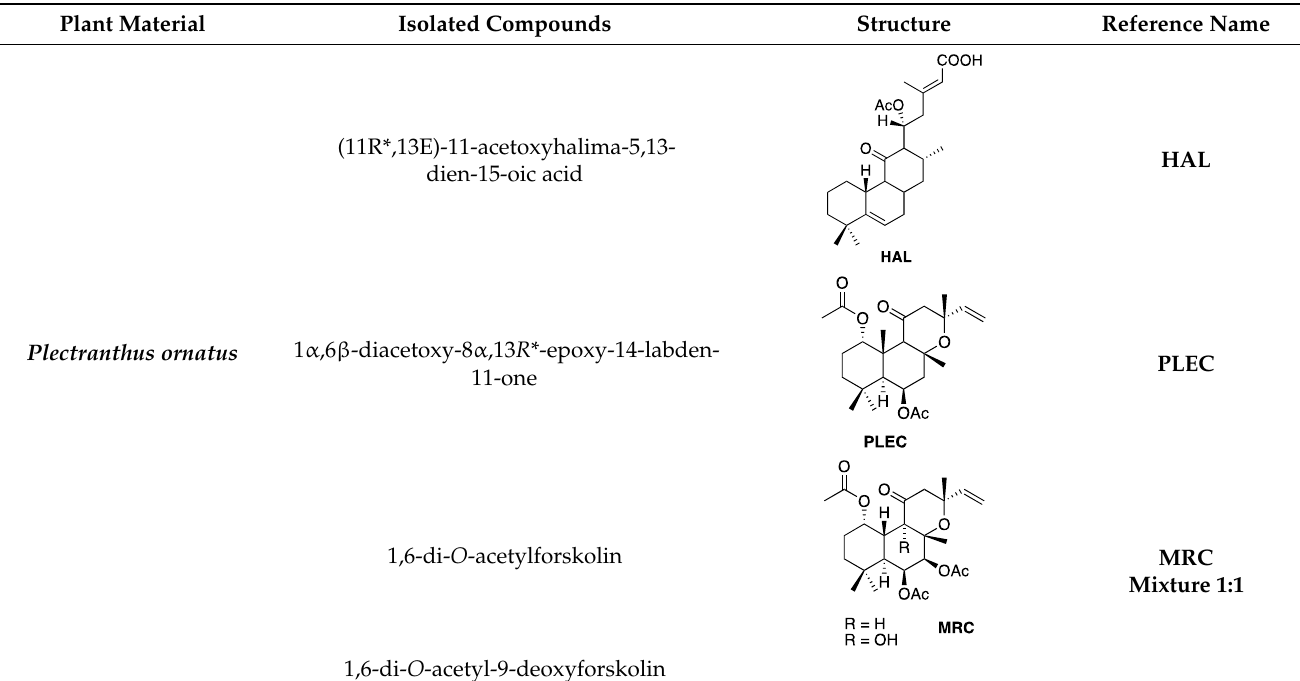
Table 1. Diterpenes isolated from the Plectranthus ornatus Codd. and their reference name. Plant Material Isolated Compounds